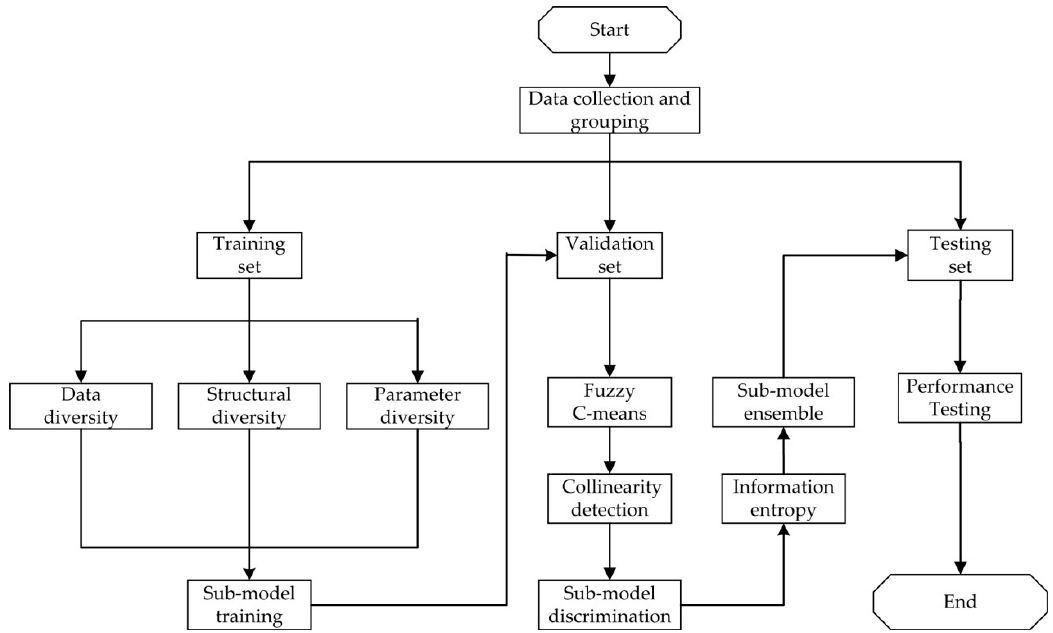
Figure 1. The implementation processes of the selective ensemble modeling method.